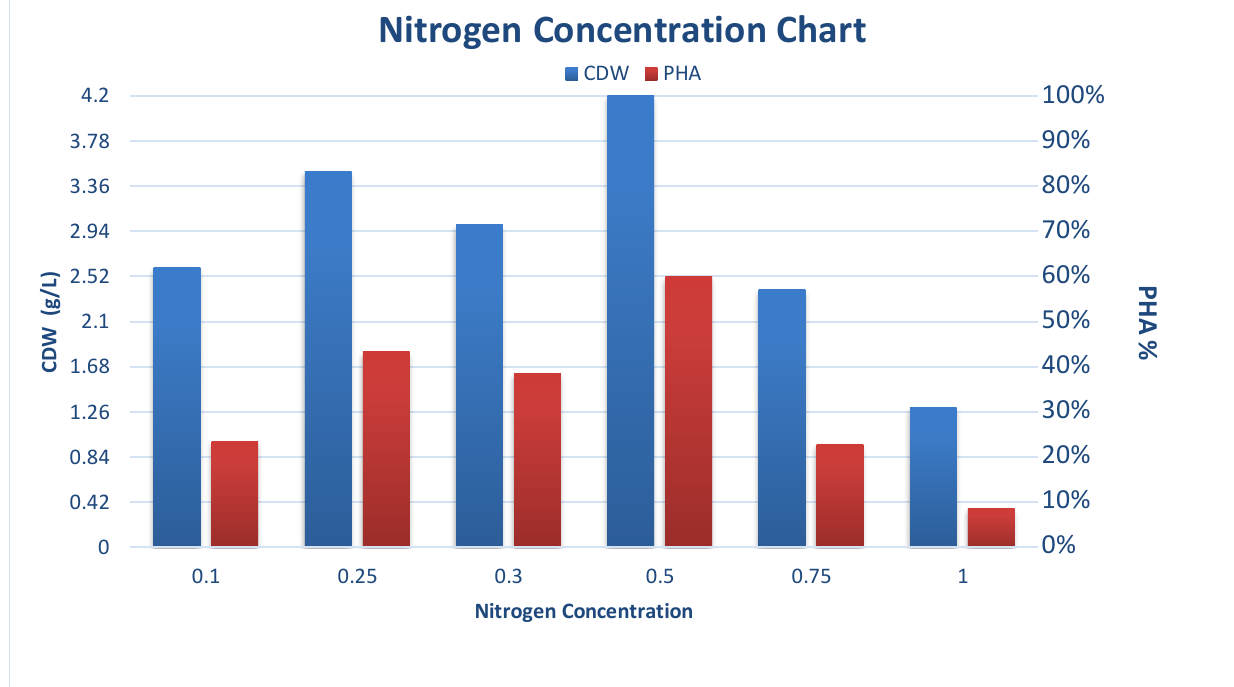
Figure 6 : Effect of different nitrogen source concentrations on bacterial growth and PHA